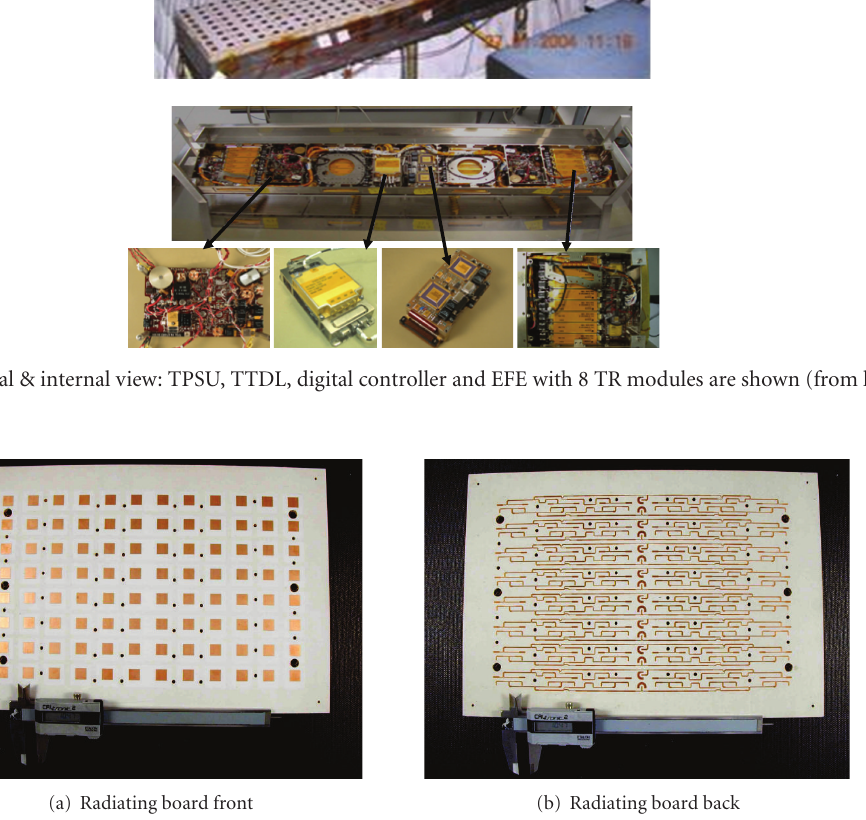
Figure 6: Radiating board: patches side and BFNs